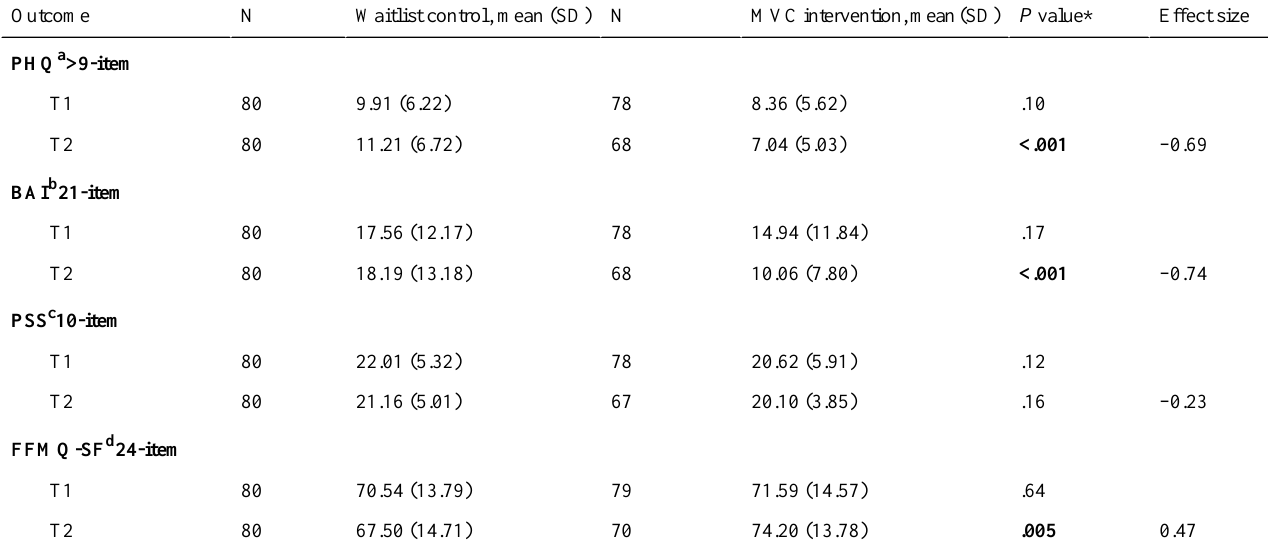
Table 3. Descriptive statistics for depression, anxiety, stress, and mindfulness